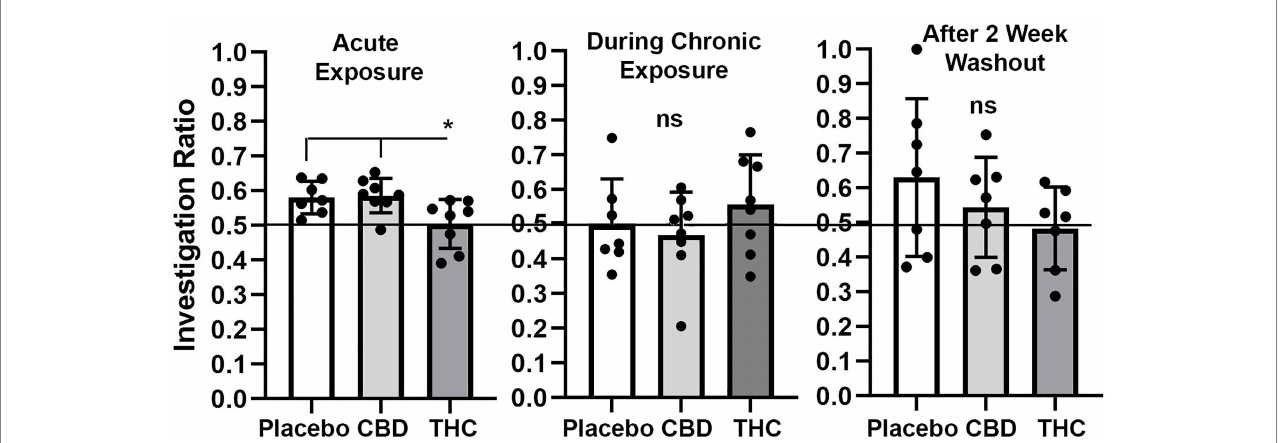
FIGURE 4 Novel object recognition. Shown are scatter plots of the investigation ratio (time spent investigating the novel object / time spent investigating both objects) using single-sample, two-tailed t-tests, and performance was compared to chance (i.e., IR = 0.5) shown by the horizontal line. measurements were taken during first exposure to inhaled cannabis high in CBD, Δ 9-THC, or placebo and again at D27 of the 28 days of chronic exposure and following a two- week washout. The bar and line represent the mean and SD, respectively. (* p < 0.05).